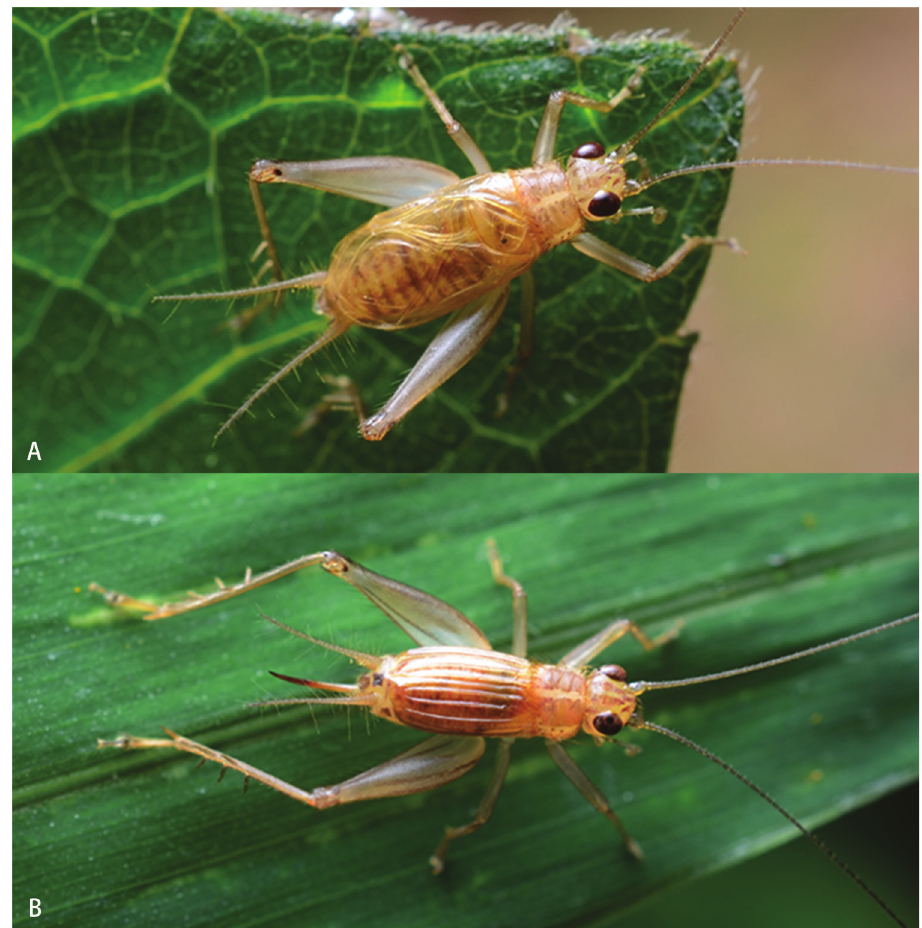
Figure 5. Habitus (alive) of A. manereserratus sp. nov. on leaf A male B female (photography: Zhang,